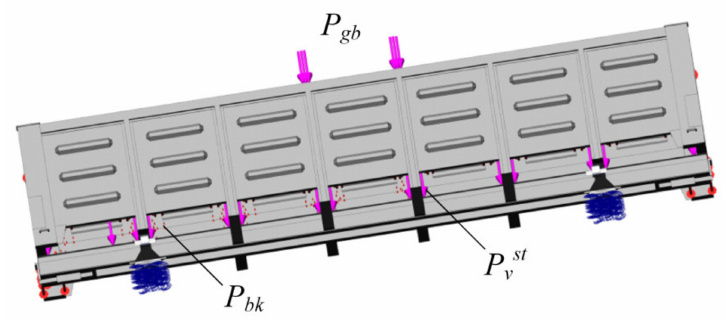
Figure 8. Computational scheme of a gondola